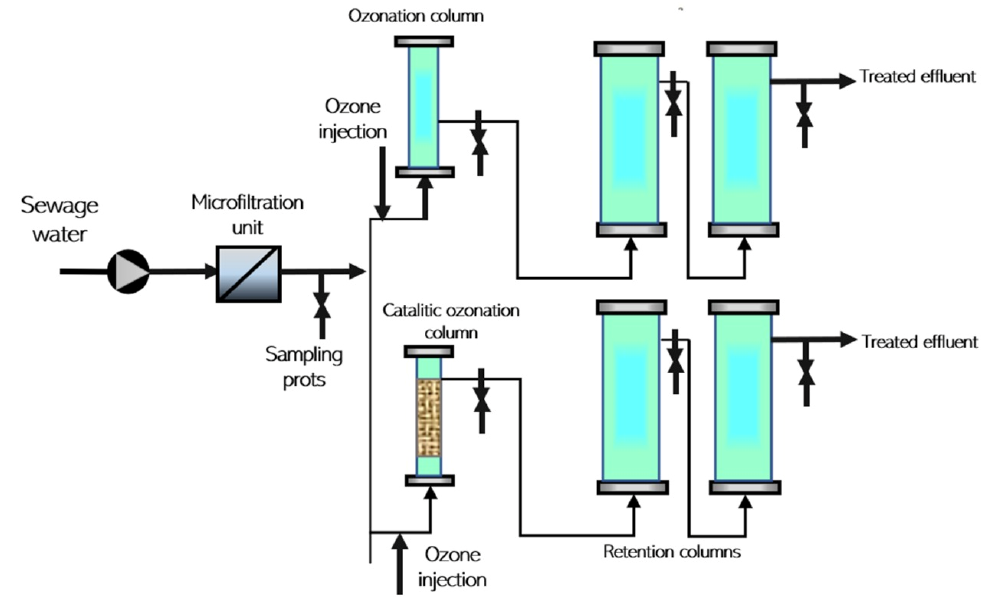
Figure 4. Ozonation process.